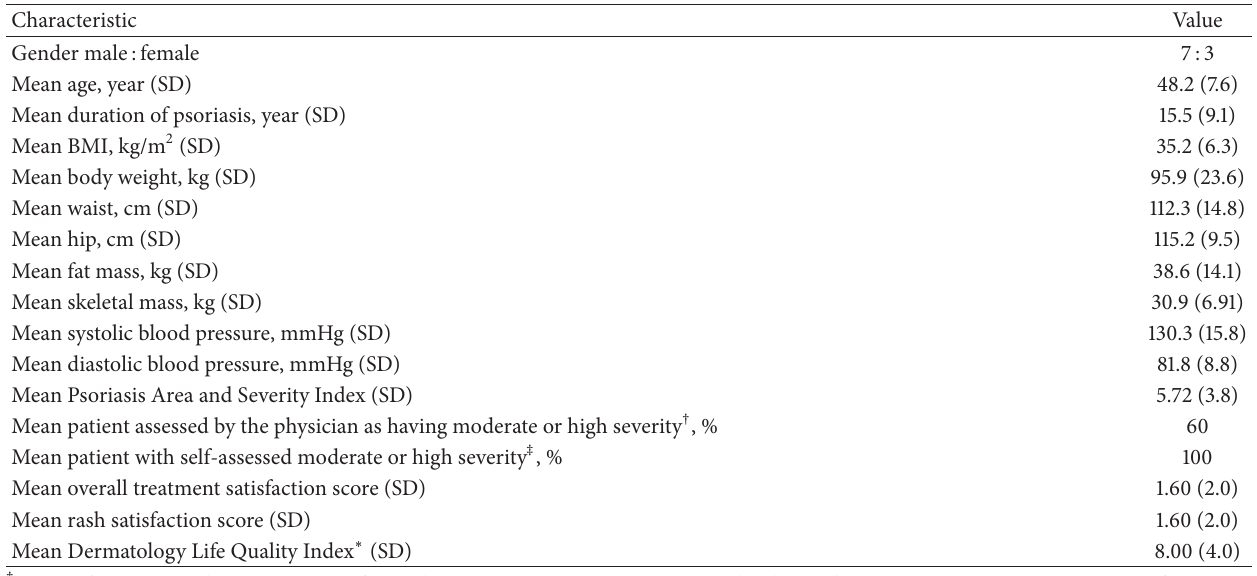
Table 1: Baseline characteristics of patients.